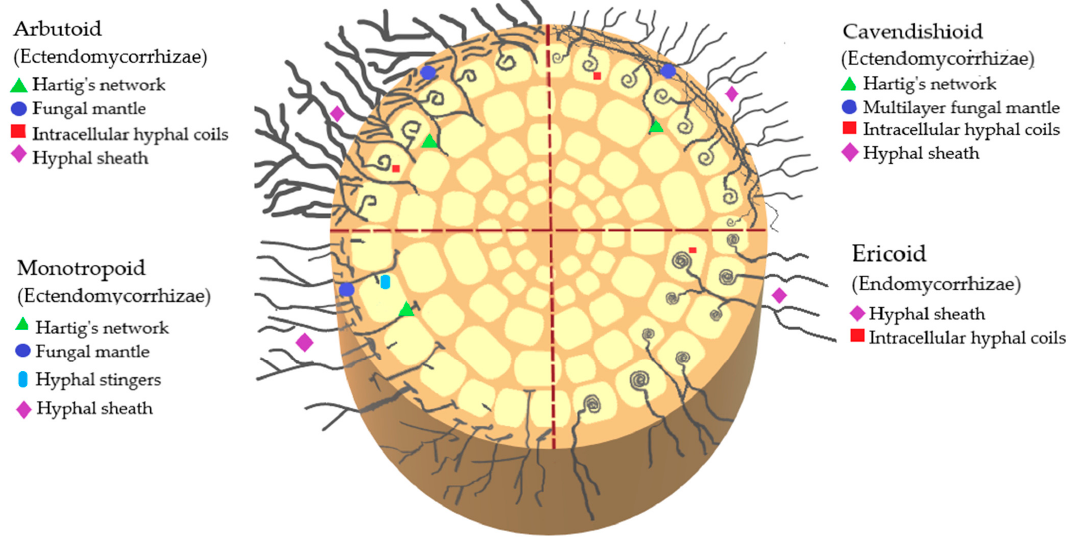
Figure 2. Schematic representation of endomycorrhizae and ectendomycorrhizae that interact with ericaceous plants.